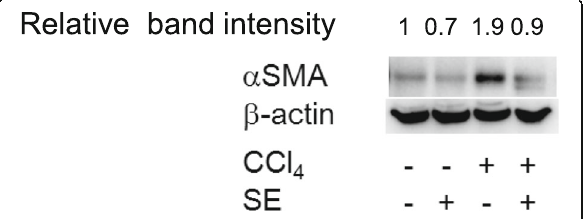
Fig. 6 Effect of SE on levels of hepatic α SMA levels. Animals treated as described in Fig. 2 were euthanized at 72 h post intraperitoneal injection, and liver tissues were isolated. Proteins were isolated, and western blotting was performed. β -actin was used as the internal control. Band intensity was measured using ImageJ